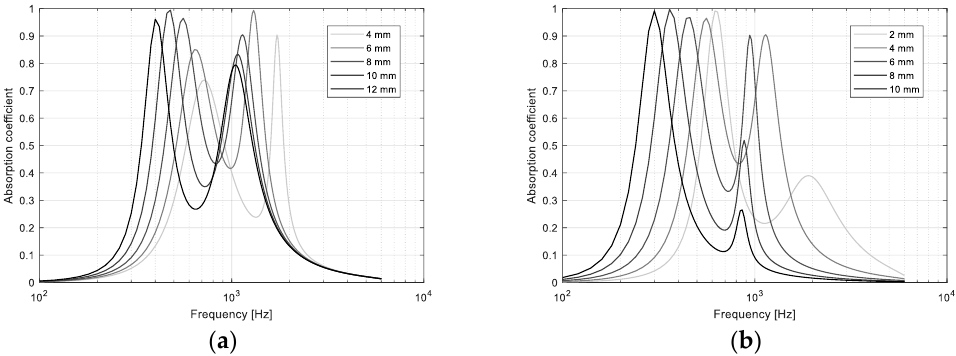
Figure 8. Sound absorption coefficient of a double layer perforated panel for different parameter modifications: ( a ) distance between holes of the innermost layer; and, ( b ) distance between holes of the outermost layer.